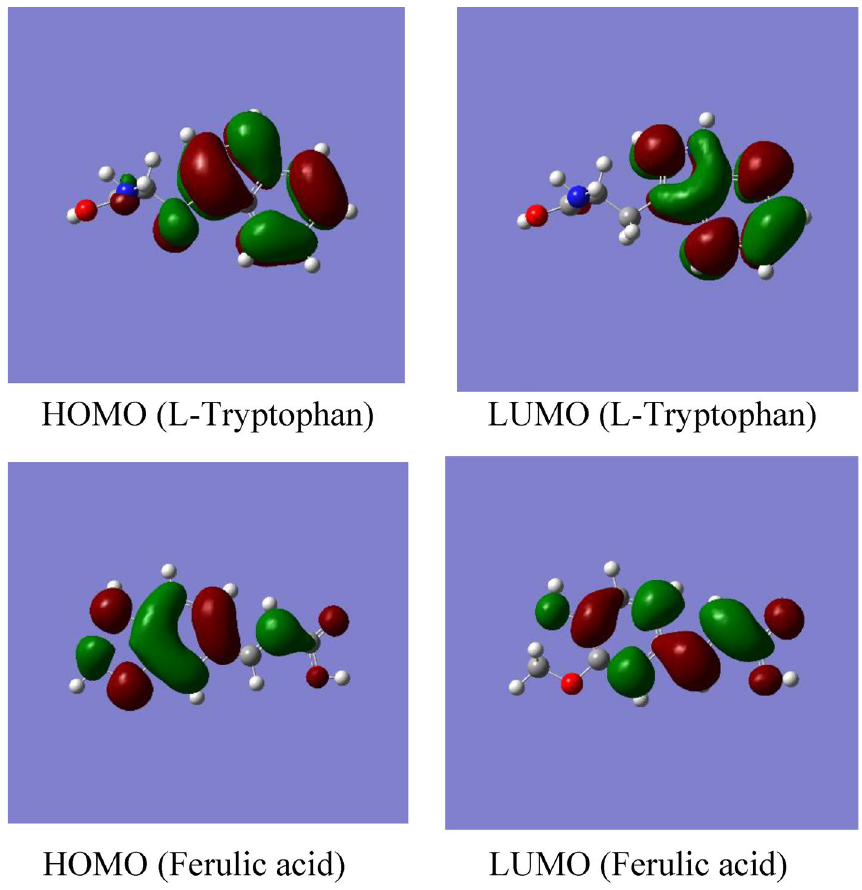
Figure 12. Optimized structure, E HOMO, and E LUMO of inhibitors for l-Tryptophan and Ferulic acid.